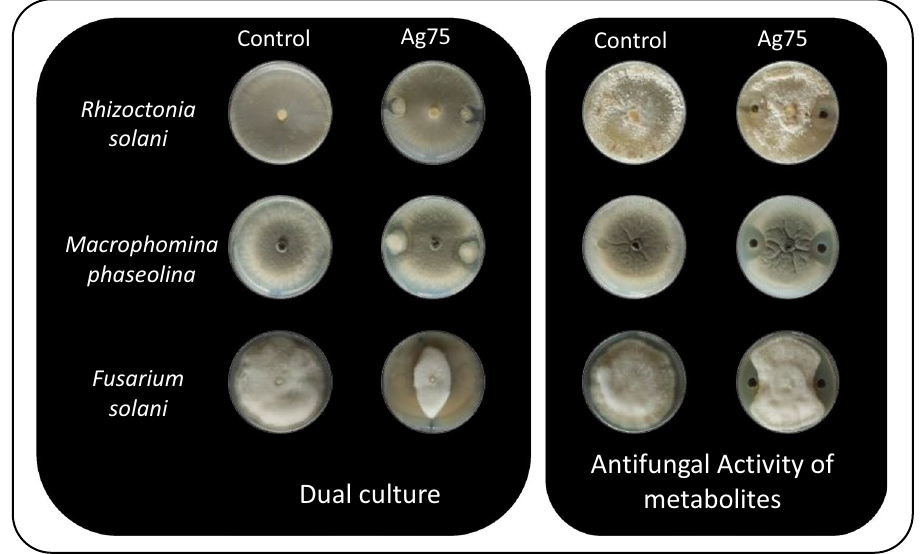
Figure 3. Mycelial growth inhibition of the fungi Rhizoctonia solani , Macrophomina phaseolina , and Fusarium solani using dual culture and cell-free supernatant of the Ag75